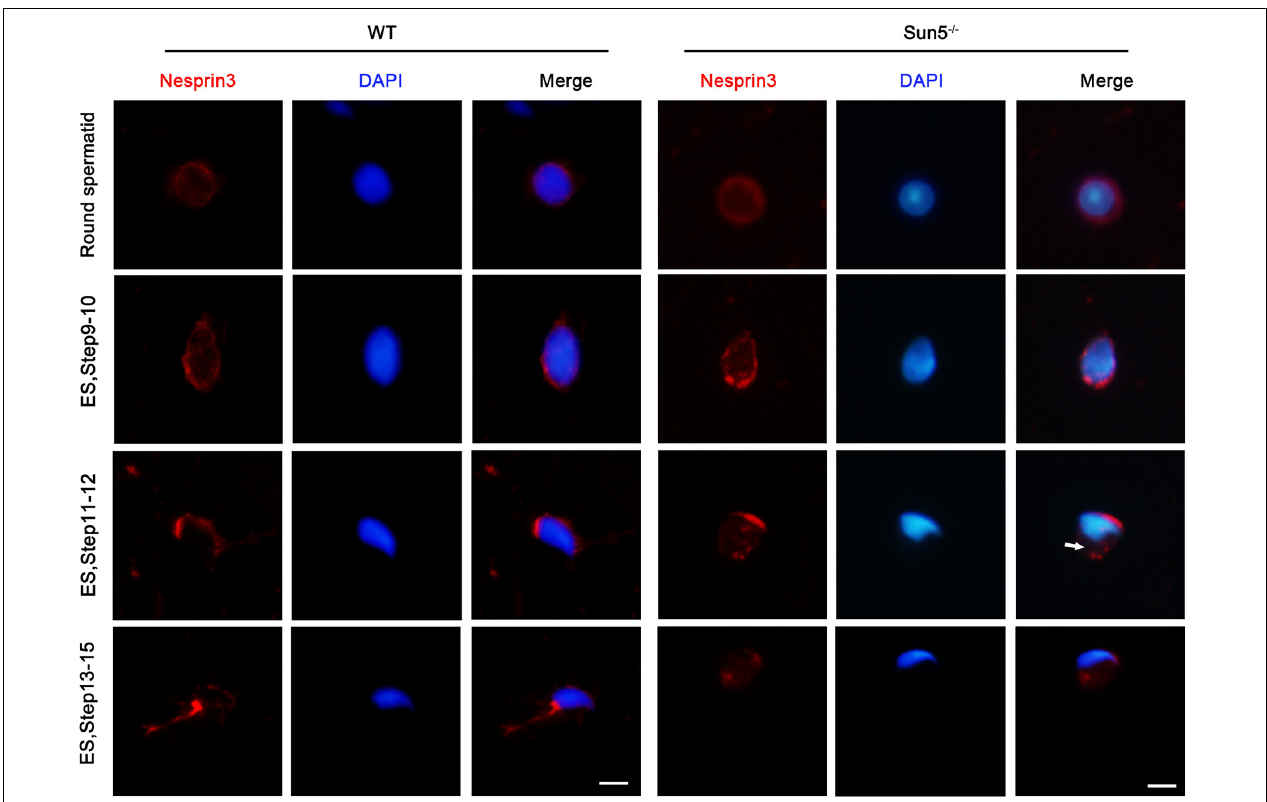
FIGURE 6 | Sun5 deficiency changed the localization of Nesprin3. In round spermatids, Nesprin3 was detected in the nuclear membrane in WT mice but in the perinuclear cytoplasm in Sun5 − / − mice. In steps 9–10 and 11–12, Nesprin3 moved anterior and posterior to the nucleus with cell elongation in WT mice, whereas it migrated to the anterior region to a greater degree and no longer clung to the implantation fossa at the posterior region in Sun5 − / − mice. In steps 13–15, Nesprin3 was located at the acrosome region and the implantation fossa in WT mice, whereas it lost its localization in the nuclear membrane in Sun5 − / − mice. ES, elongated spermatid. Bars: 5 µ